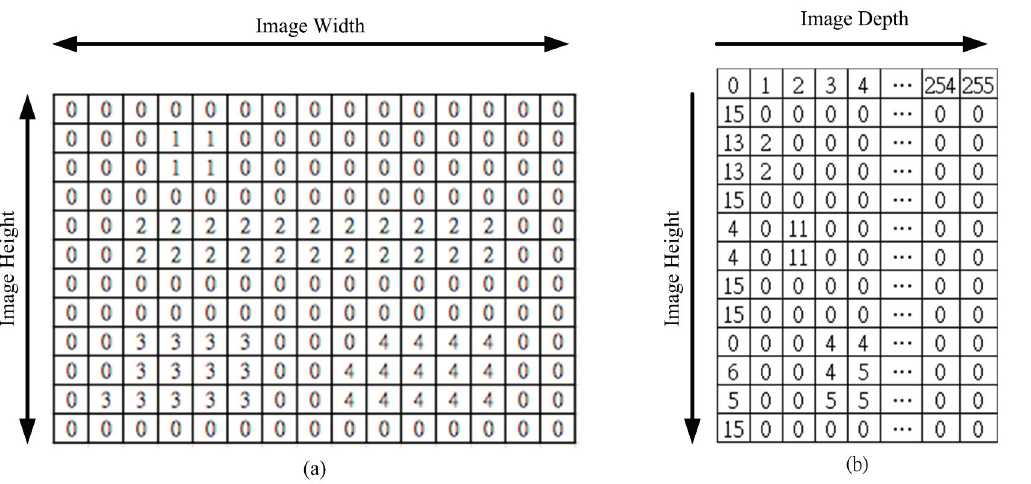
Figure 4. A schematic diagram of the V disparity map. ( a ) Depth map; ( b ) V disparity